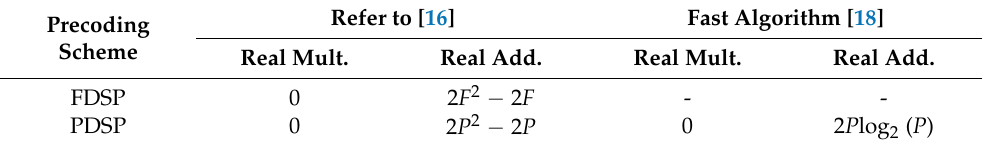
Table 1. WHT-based FDSP/PDSP computational complexity comparison.